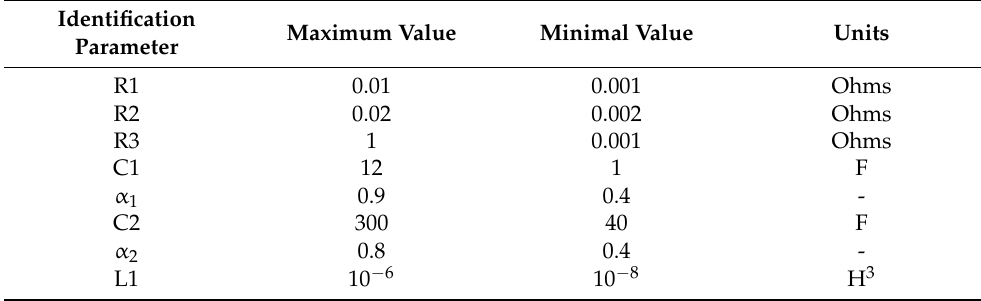
Table 4. Identification parameter set maximum and minimum values applied in